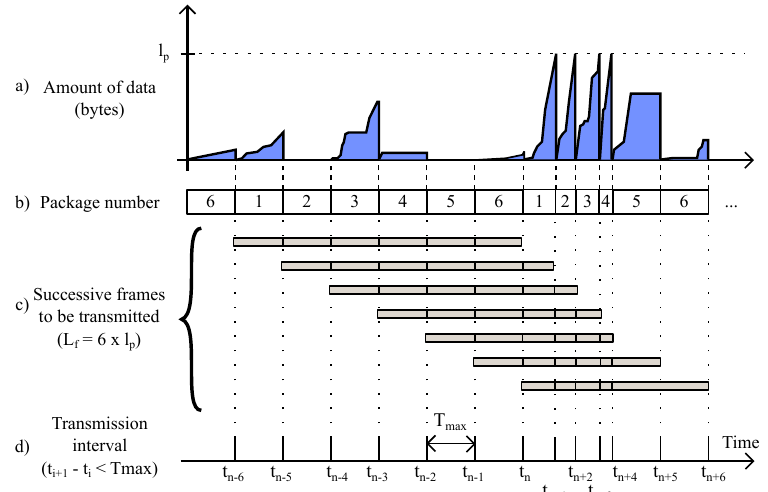
Figure 2. Operating principle of the sliding window for ensuring the redundancy of transmitted data from smart water meters through successive frames